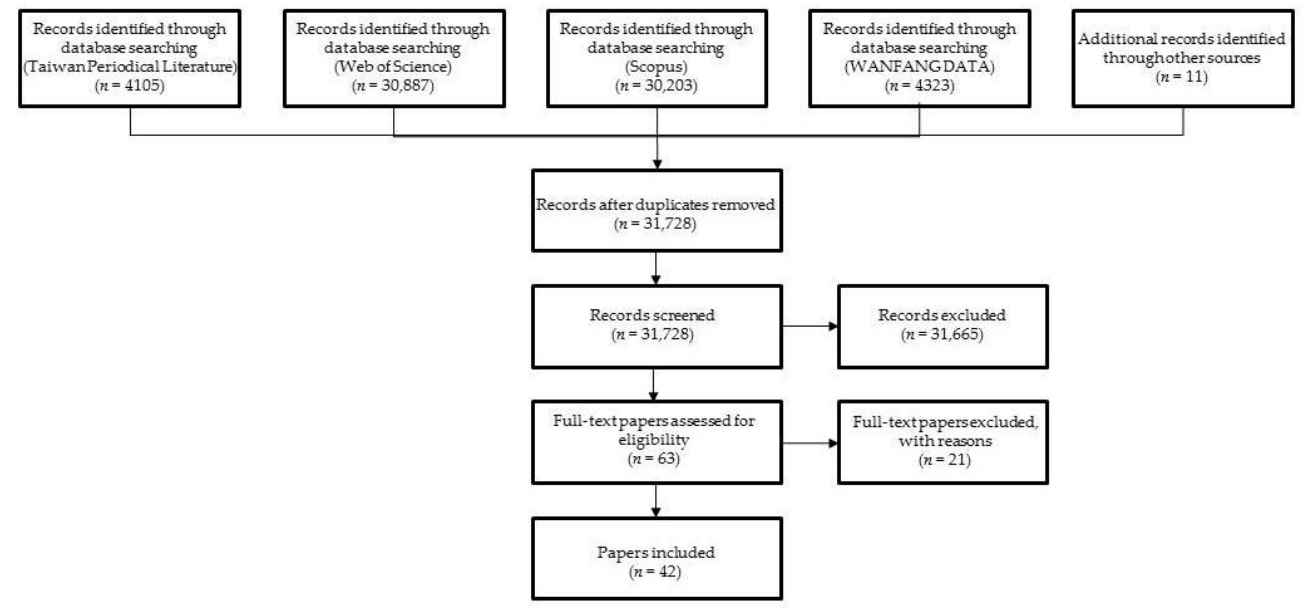
Figure 1. Flow chart of the screening process.